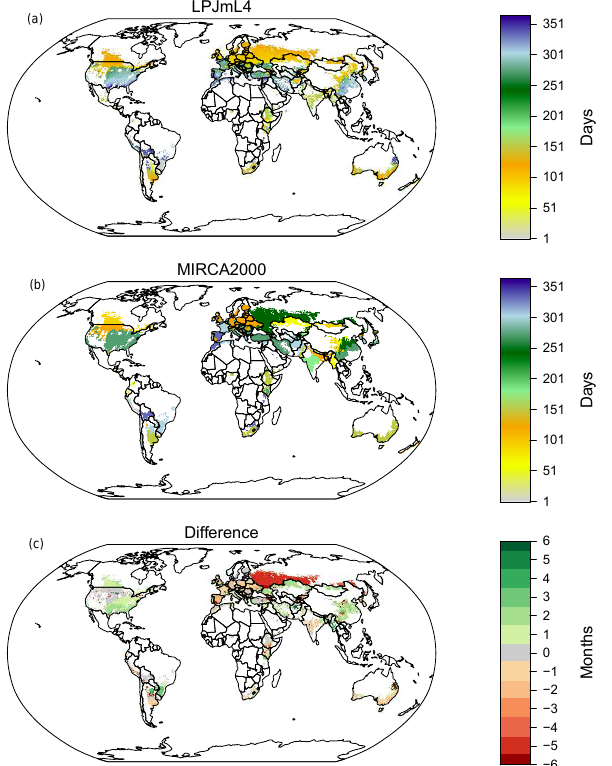
Figure 14. Evaluation of sowing dates for wheat. From (a) to (c) : simulated (LPJmL4) sowing date, observed (MIRCA2000) sowing date, and difference between simulated and observed sowing date. Green colours (red colours) in the difference map indicate that sim- ulated sowing dates are too late (too early) compared to observa- tions. White indicates crop area with less than 0.001% of the grid cell area. Regions without seasonality are not